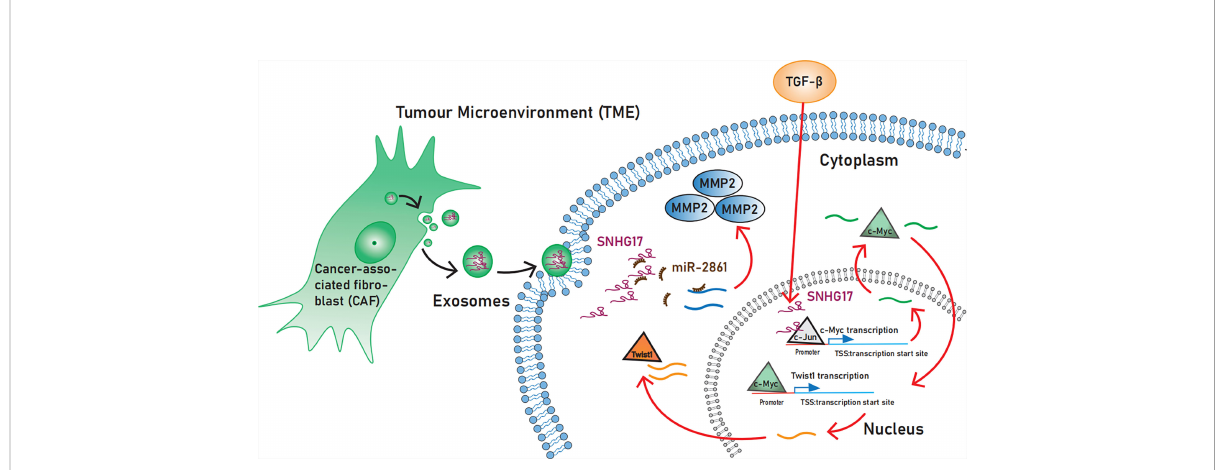
FIGURE 2 The role SNHG17 plays in activating invasion and metastasis. SNHG17 acts as a transcriptional co-activator by recruiting the transcription factor c-Jun to the c-Myc promoter region, and promotes the expression of the EMT-associated transcription factor Twist1 via c-Myc. In the Extracellular, SNHG17 can be secreted by tumor-associated fi broblasts and target MMP2 in the form of exosomes. EMT, Epithelial-mesenchymal transition; MMP2, Matrix metalloproteinases